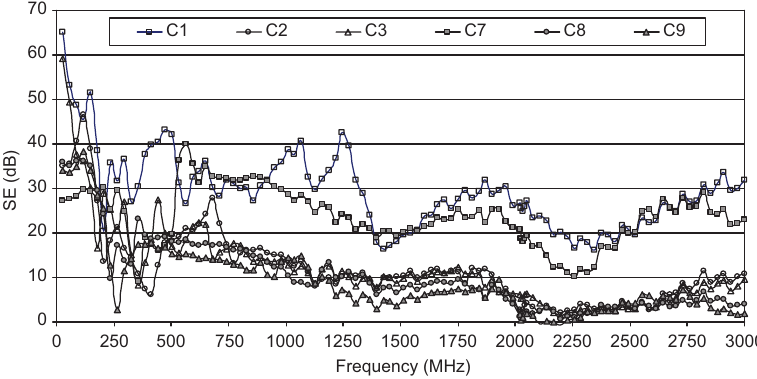
Figure 9 EMSE values of C1 to C3 and C7 to C9 composite laminates.